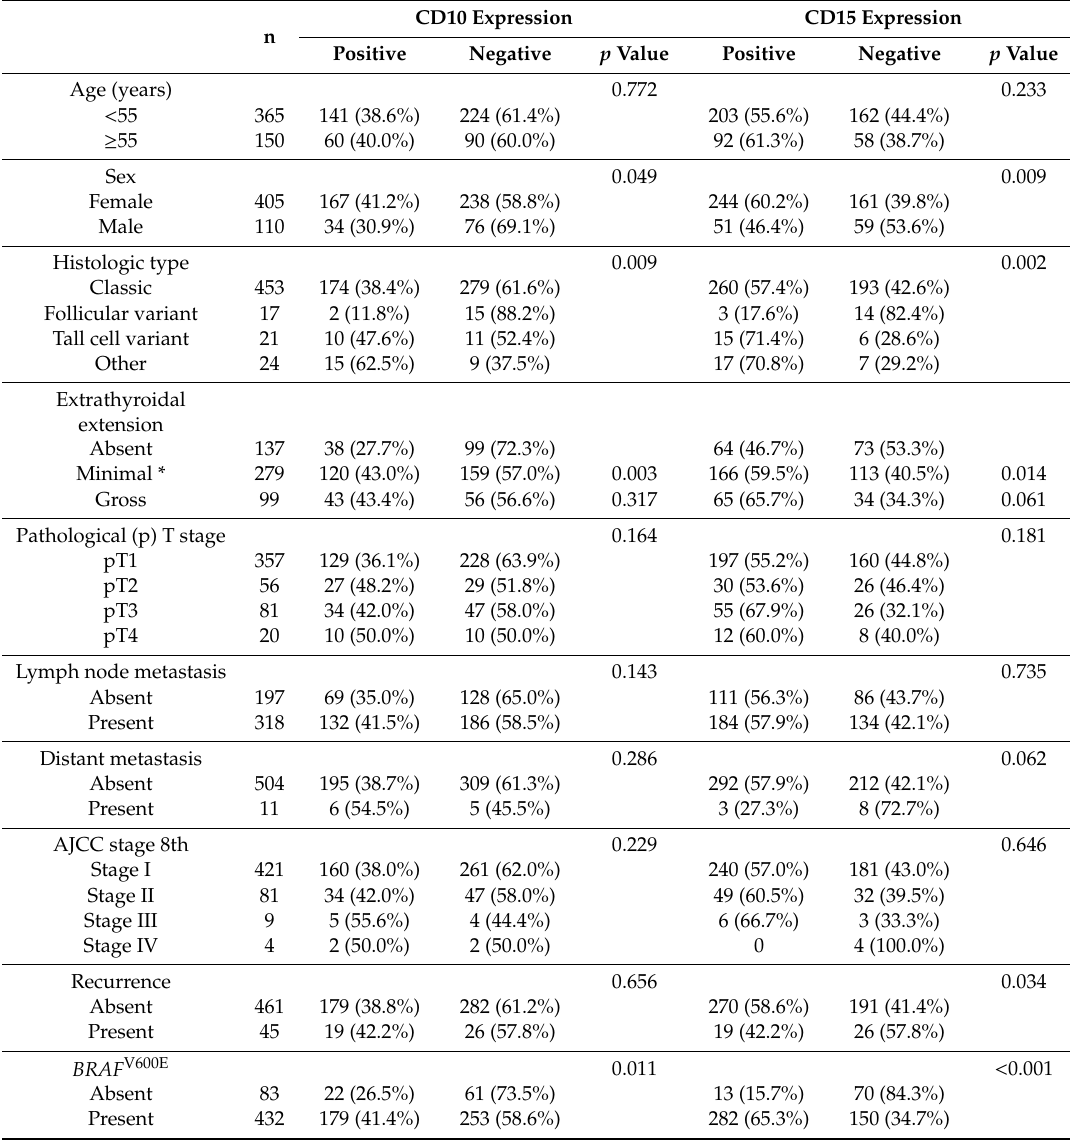
Table 1. Relationship between clinicopathologic characteristics and the expression of CD10 and CD15 in 515 patients with papillary thyroid